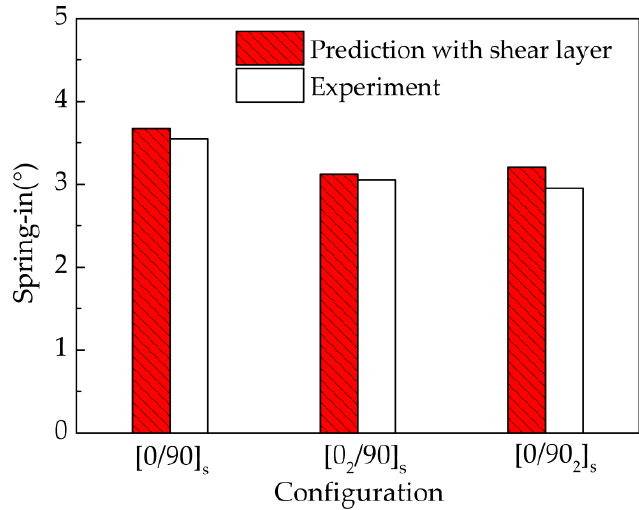
Figure 8. Comparison of the predicted and experimental spring-in for the U-shaped parts.